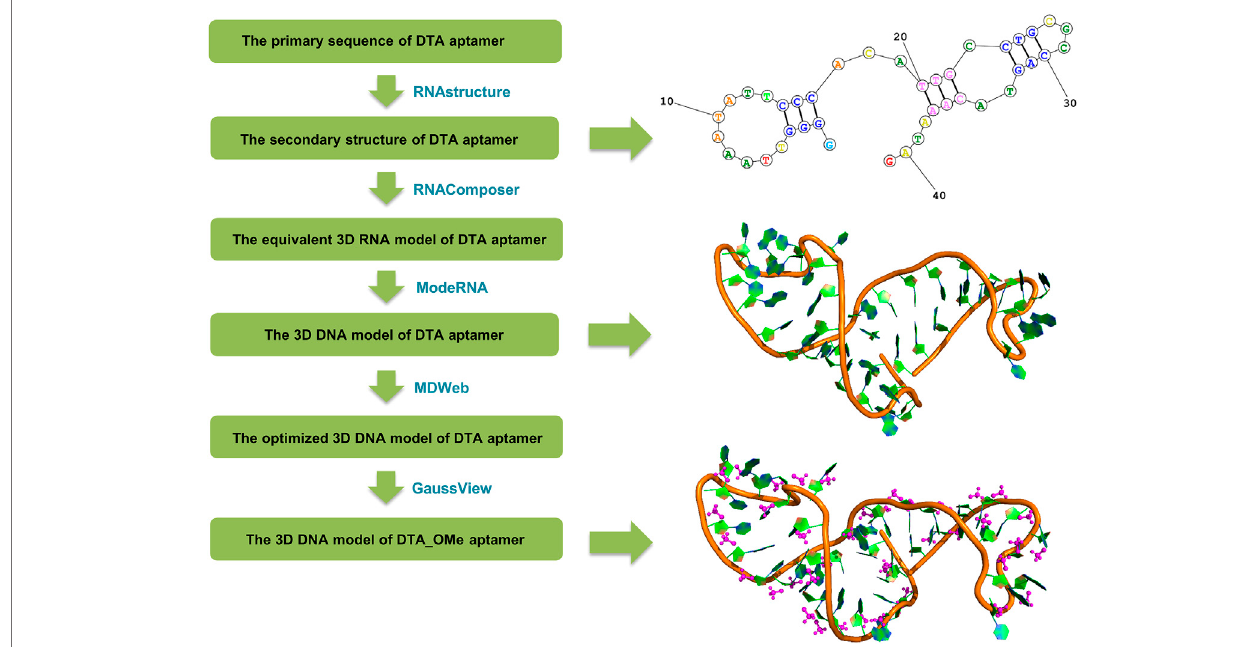
FIGURE 2 | Flow chart of the DTA and DTA_OMe aptamers ’ structure prediction originated from the primary sequence.